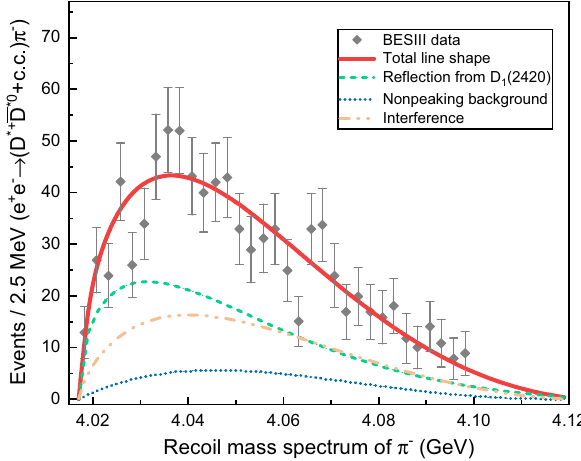
Fig. 3 The same as Fig. 2 but for recoil mass spectrum of π − of e + e − → D ∗+ ¯ D ∗ 0 π − . The broad peak corresponds to Z c ( 4025